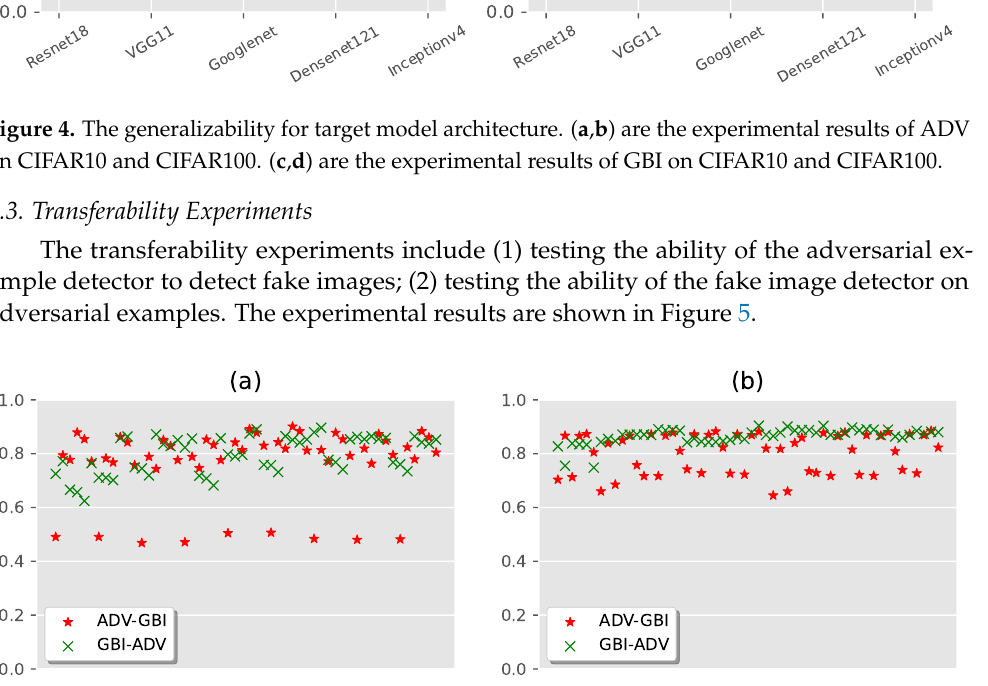
Figure 5. The result of transferability experiments. ( a ) is the experimental result on CIFAR10. ( b ) is the experimental result on